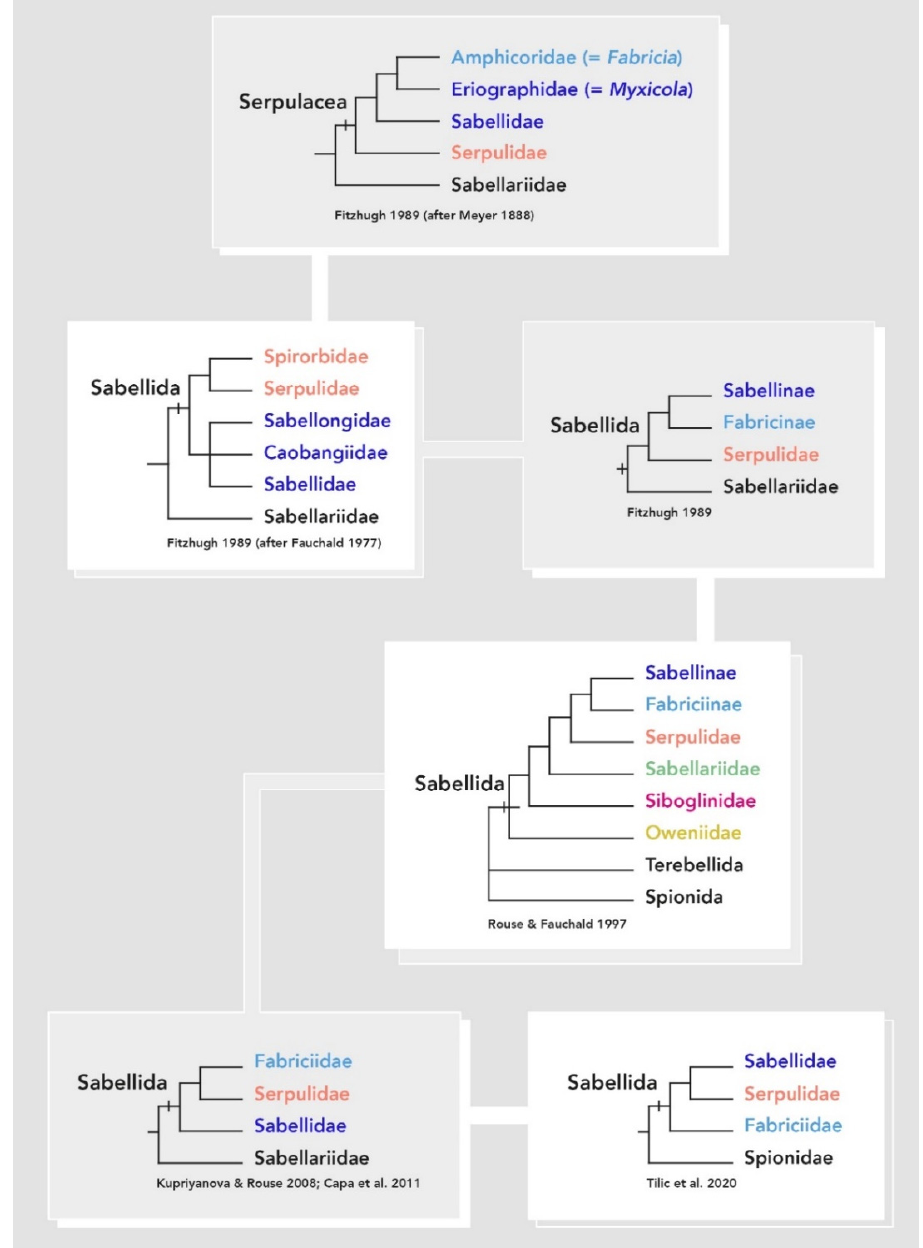
Figure 2. History of the evolutionary hypotheses within Sabellida. The coloured taxa indicate the groups that had been considered as members of Sabellida (or Serpulacea) according to the represented phylogenetic hypotheses. In light blue are members of the currently accepted Fabriciidae, in dark blue are Sabellidae and Serpulidae are in orange. In green, pink and yellow are other taxa previously considered as Sabellida.